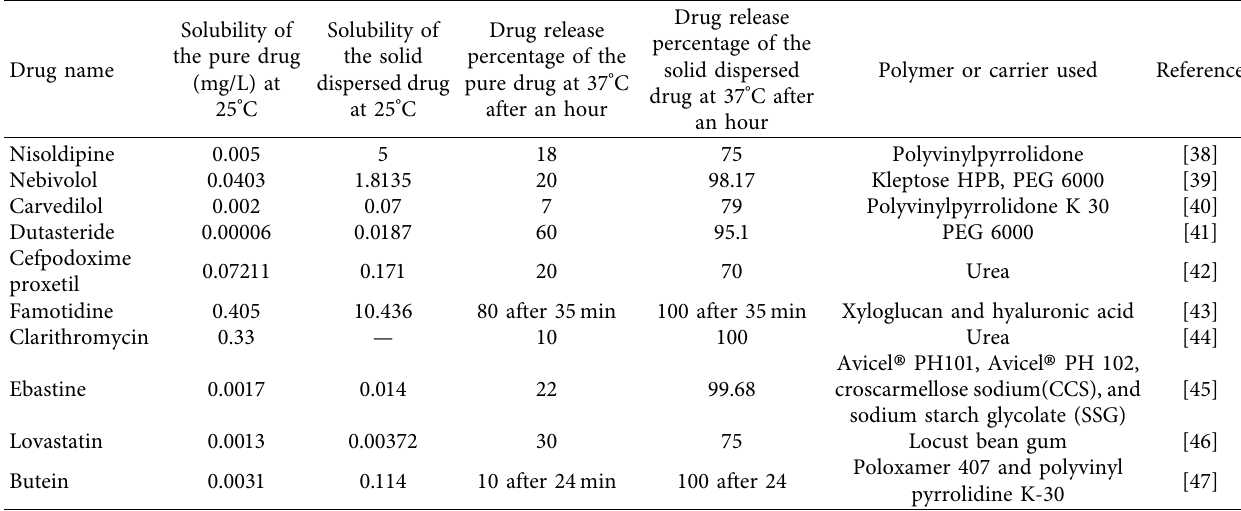
Table 5: Shows examples of decent case studies for the preparation of solid dispersion using the solvent evaporation method.